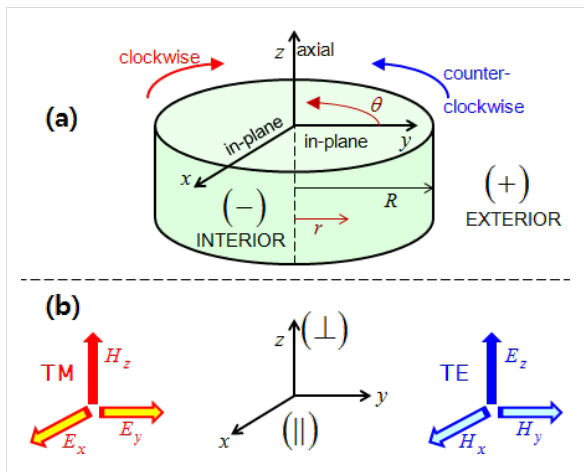
Figure 1: (a) The axial direction is along the z -axis, whereas the "in- plane" refers to the xy -plane. The superscript " − " refers to the interior of a cylinder, whereas the superscript "+" refers to the exterior. A thin layer lies between the interior and exterior dielectric media. (b) A schematic for the TE and TM